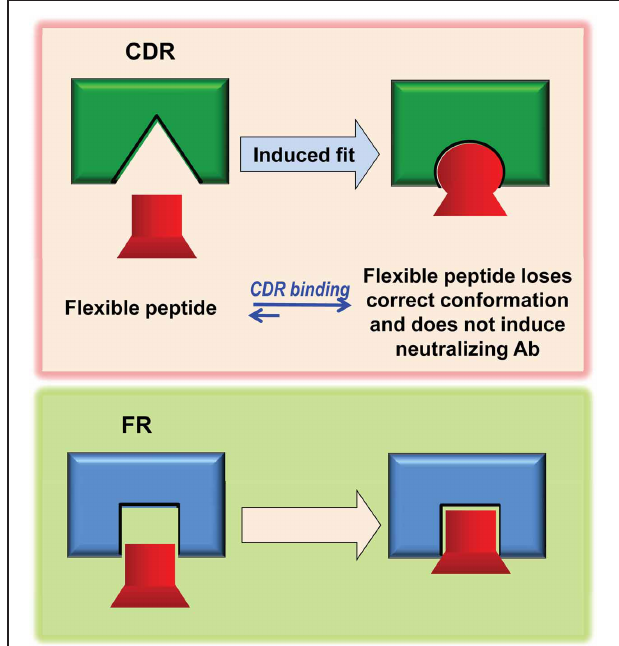
FIGURE 5 | Hypothetical mechanism for induction of non-neutralizing antibodies by flexible CD4BD core mimetics. A flexible mimetic can detect innate antibodies (or B cell receptors) that utilize the FRs for CD4BD core recognition and induce the synthesis of such antibodies if mechanisms for productive B cell stimulation can be devised ( Bottom ). When used as an immunogen, the conformation of the flexible mimetic can adapt to the structure of the B cell receptor CDRs by the induced-fit mechanism, which will corrupt the adaptive antibody response and skewed the response toward production of non-neutralizing antibodies directed to the incorrect CD4BD core conformation ( Top